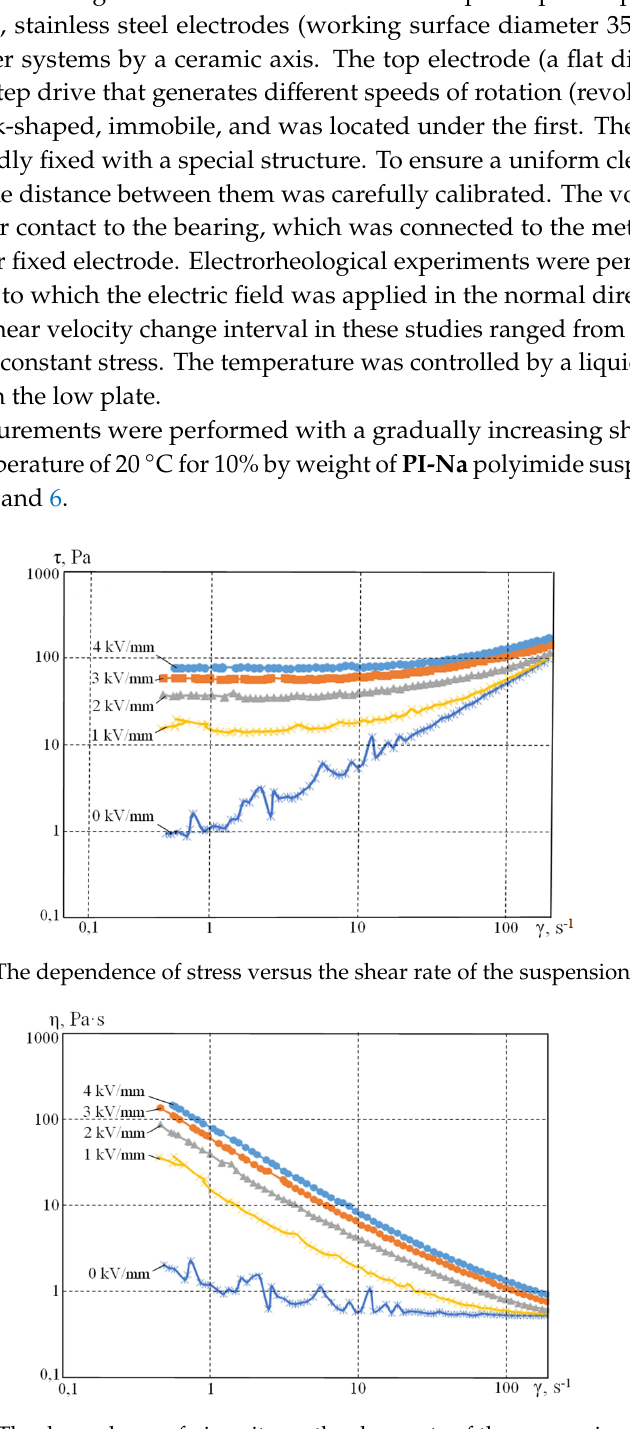
Figure 4. Micrographs of suspensions of polyimides without a field ( left ) and with a field of 2.5 kV ( right ) (scale 1 mm by the height of the picture).